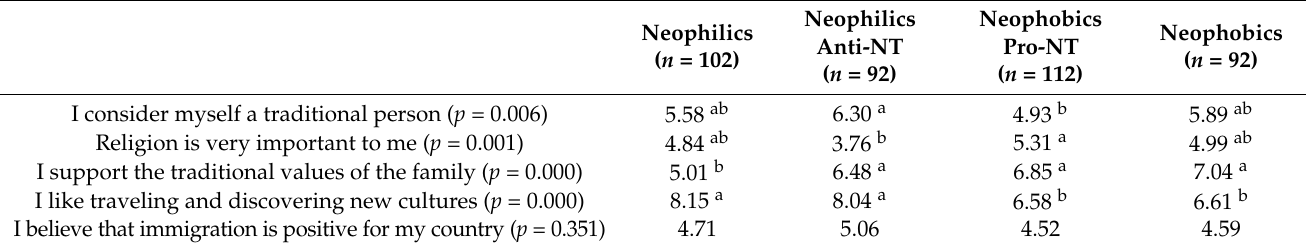
Table 6. Impacts of WN and FTN on statements about individual